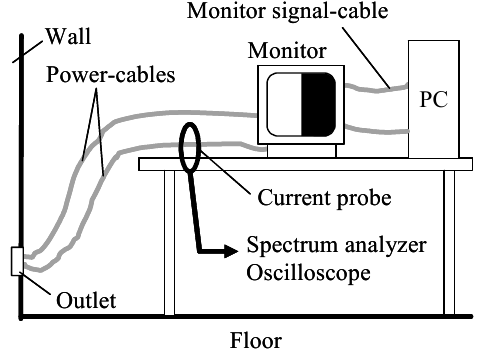
Figure 1. Measurement set-up for noise on cables.